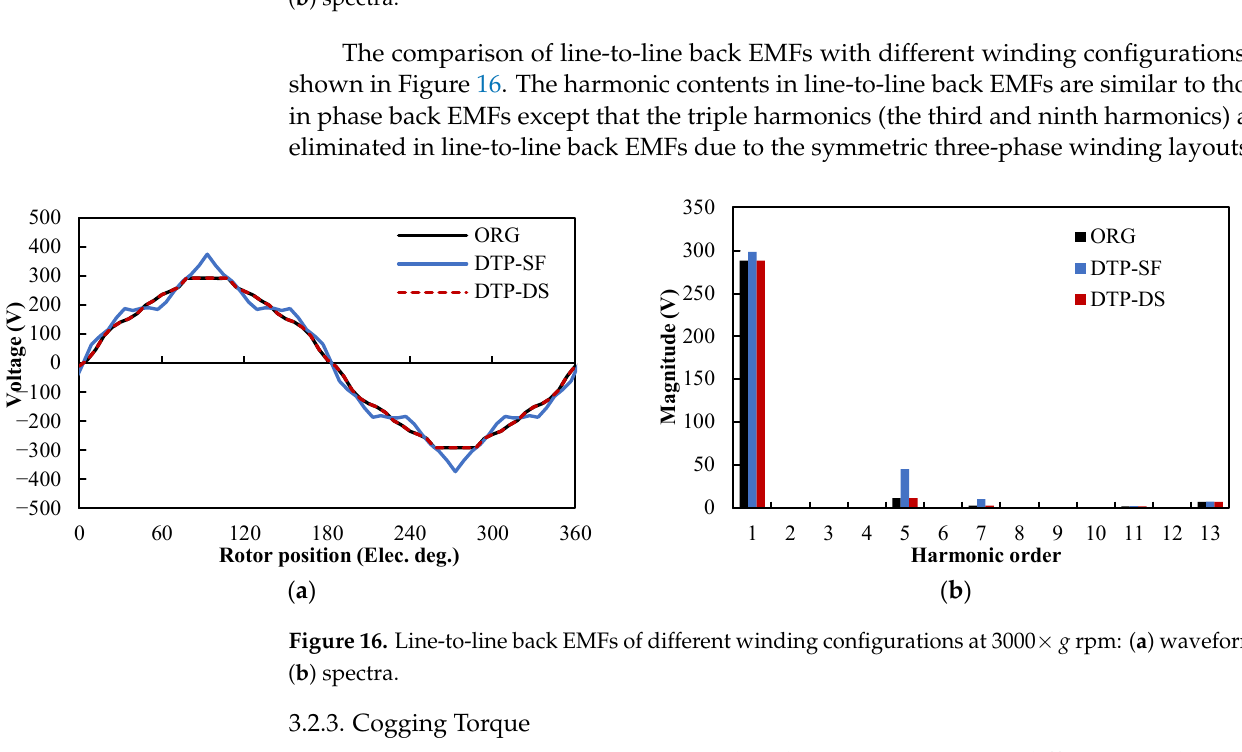
Figure 15. Phase back EMFs of different winding configurations at 3000× g rpm: ( a ) waveforms; ( b ) spectra.